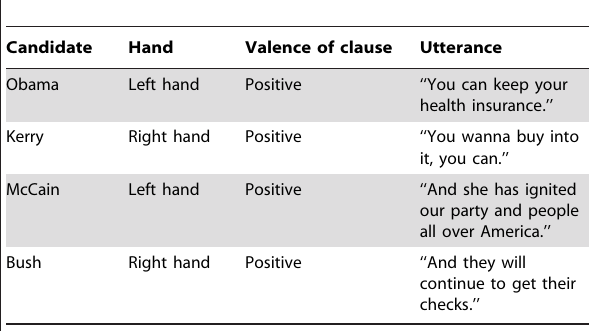
Table 2. Examples of spoken clauses corresponding to dominant-hand gestures by each candidate.